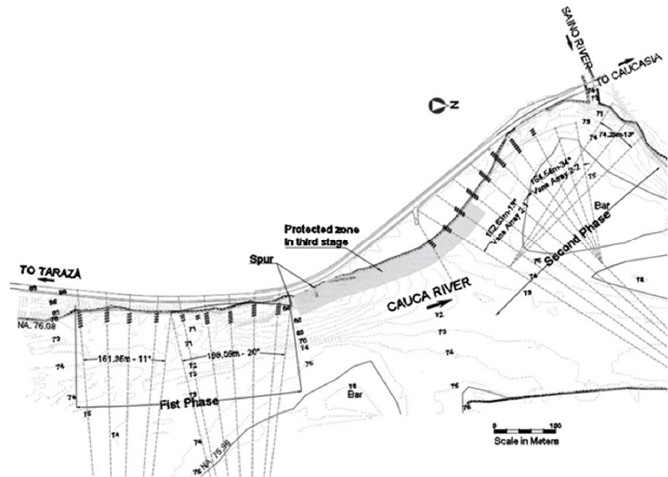
Figure 18. Cauca River, Guarumo: topo-batimetry and sector geometry for the design of the submerged vane fields (Hidroconsulta [11]).